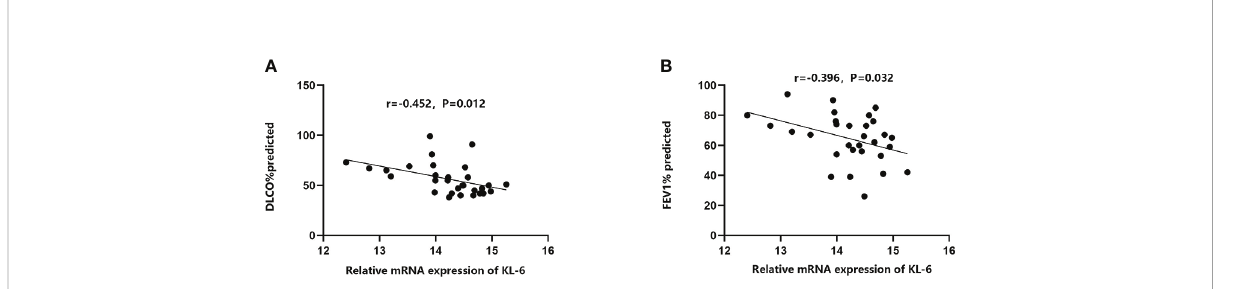
FIGURE 6 The relationships between KL-6 mRNA levels and lung function in GSE47460. (A) KL-6 mRNA levels were negatively correlated with DLCO% predicted (r=-0.452, P=0.012); (B) KL-6 mRNA levels were negatively correlated with FEV1% predicted (r=-0.396, P=0.032).